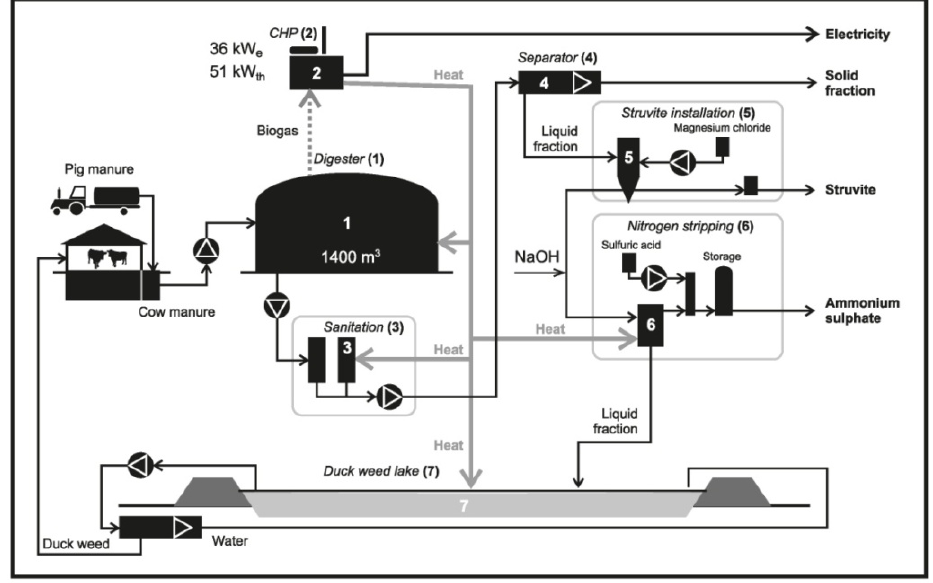
Figure 1. Scheme of the integrate bio-refinery system on farm scale.